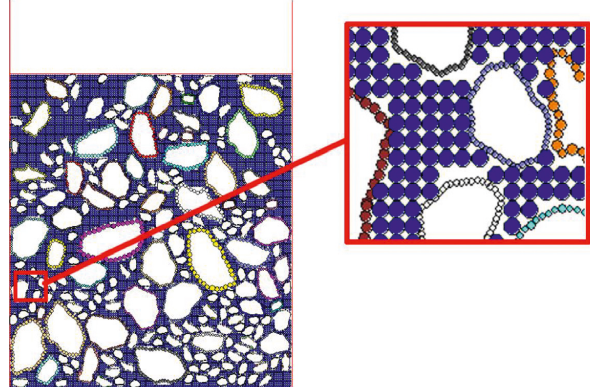
Figure 10: Filling the irregular area with balls to model the asphalt